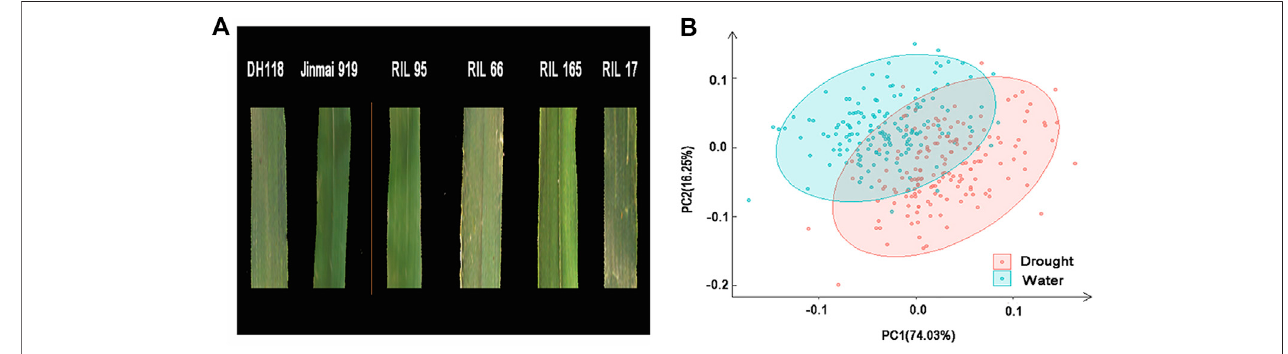
FIGURE 1 | Phenotypic characteristic of the DJ population. (A) Phenotypes of the parents and selected RILs. (B) Principal components analysis (PCA) of chlorophyllcontentof fl agleavesestimated forRILsgrownunderirrigated(water)and dryland(drought)conditions.PercentagevarianceaccountedforbyPC1andPC2 is indicated in